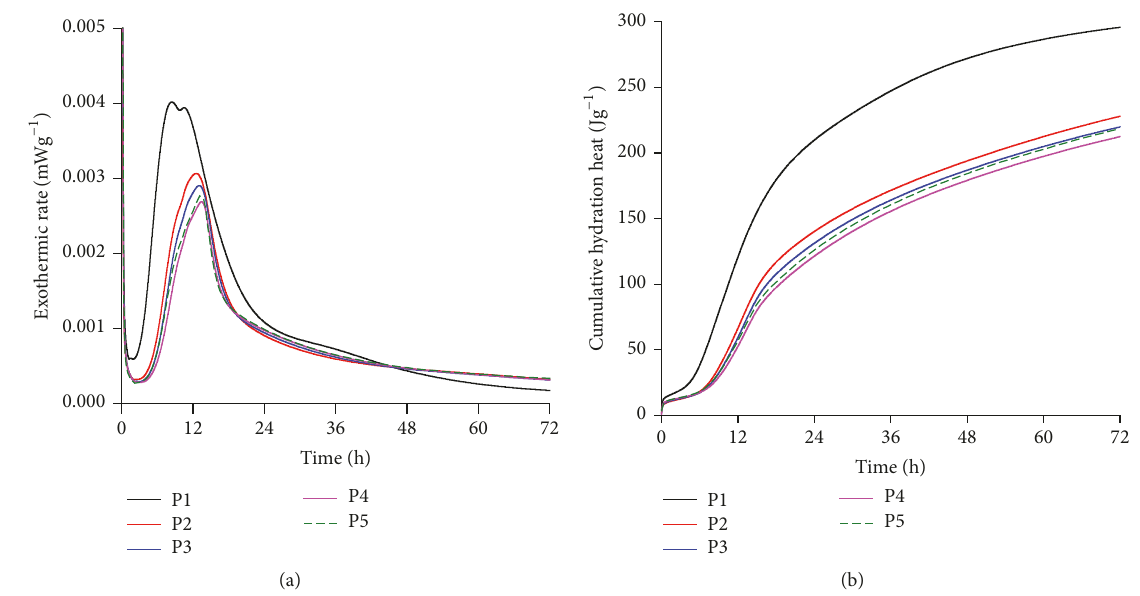
Figure 2: (a) Exothermic rate curves during the hydration of plain cement and composite binders at 20 ∘ C. (b) Cumulative heat curves during the hydration of plain cement and composite binders at 20 ∘ C.